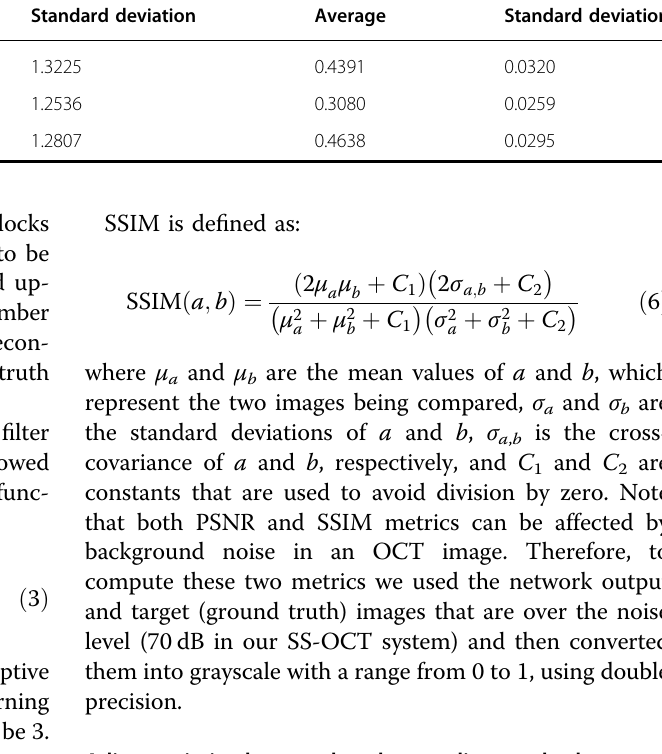
Table. 2 Comparison of PSNR and SSIM values between the network output images and the corresponding ground truth SS-OCT images for three different undersampling methods using zero interpolation (also see Fig. 7). Undersampling